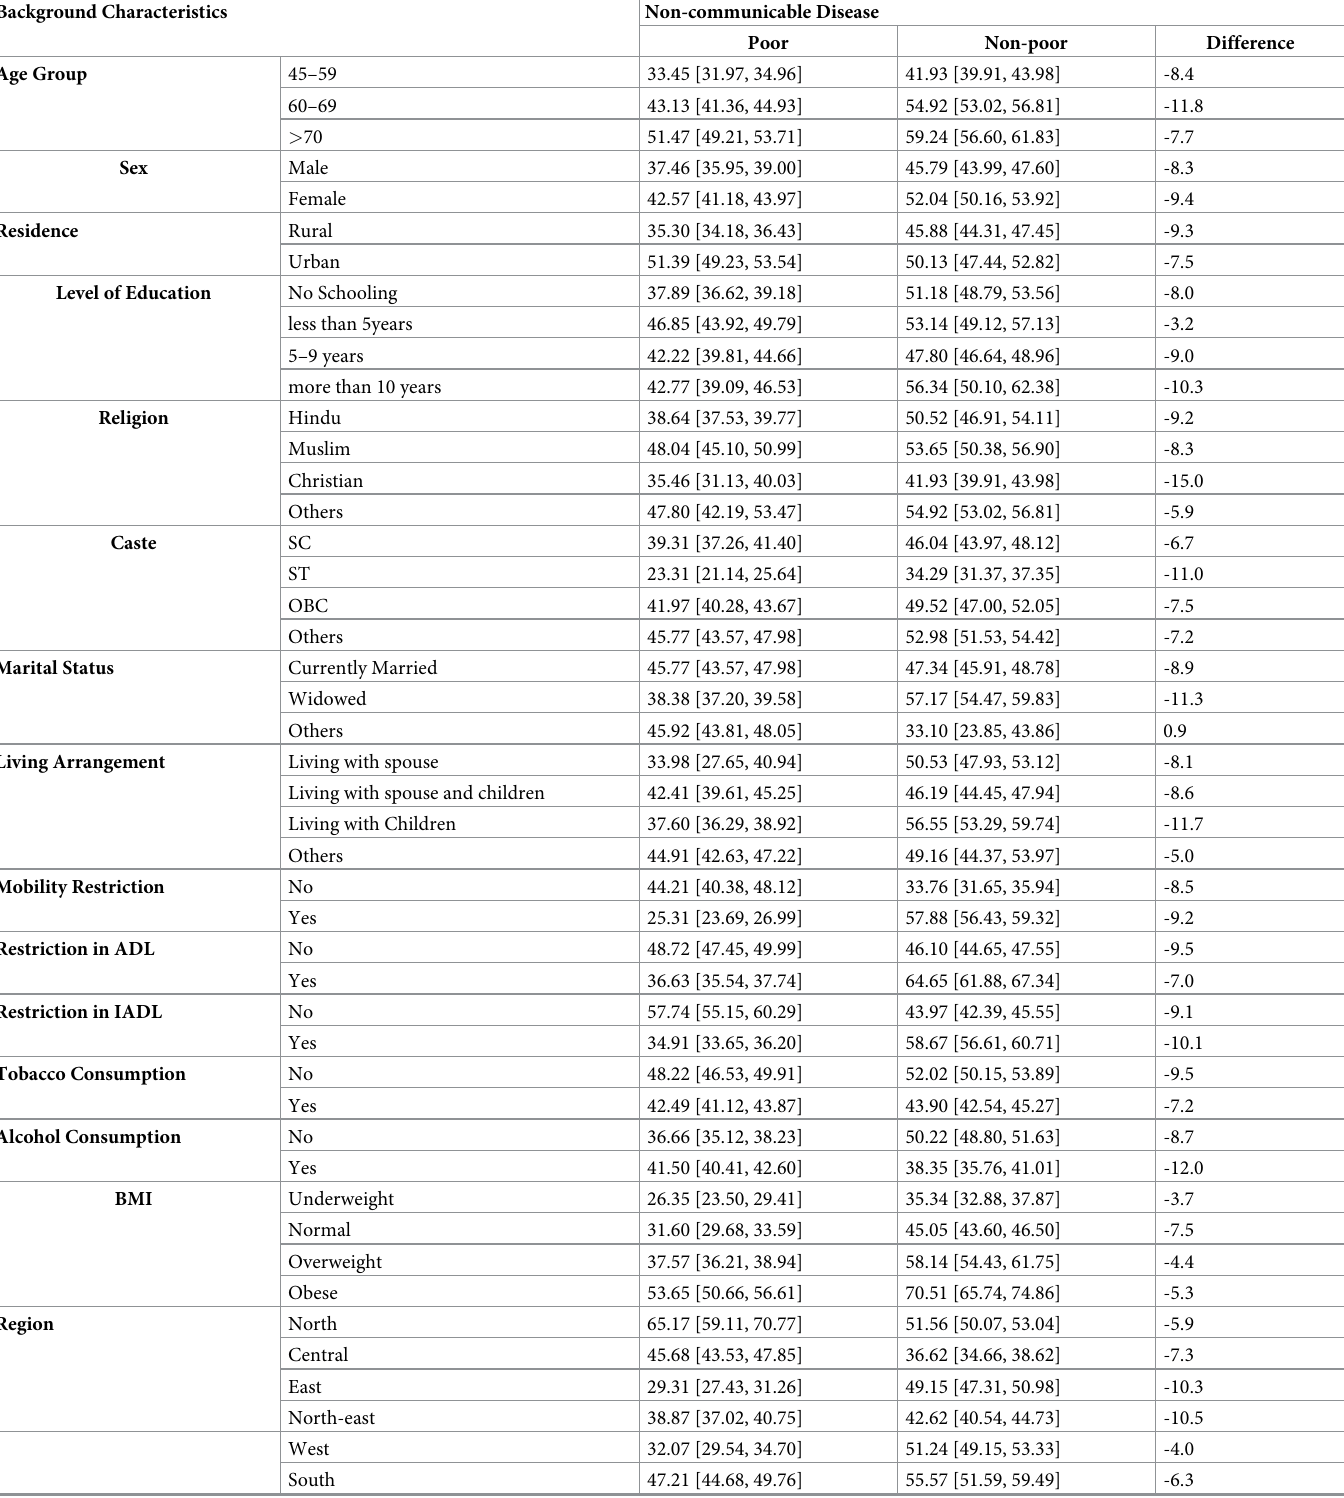
Table 3. Prevalence of non-communicable disease according to socio-economic characteristics in India. Background